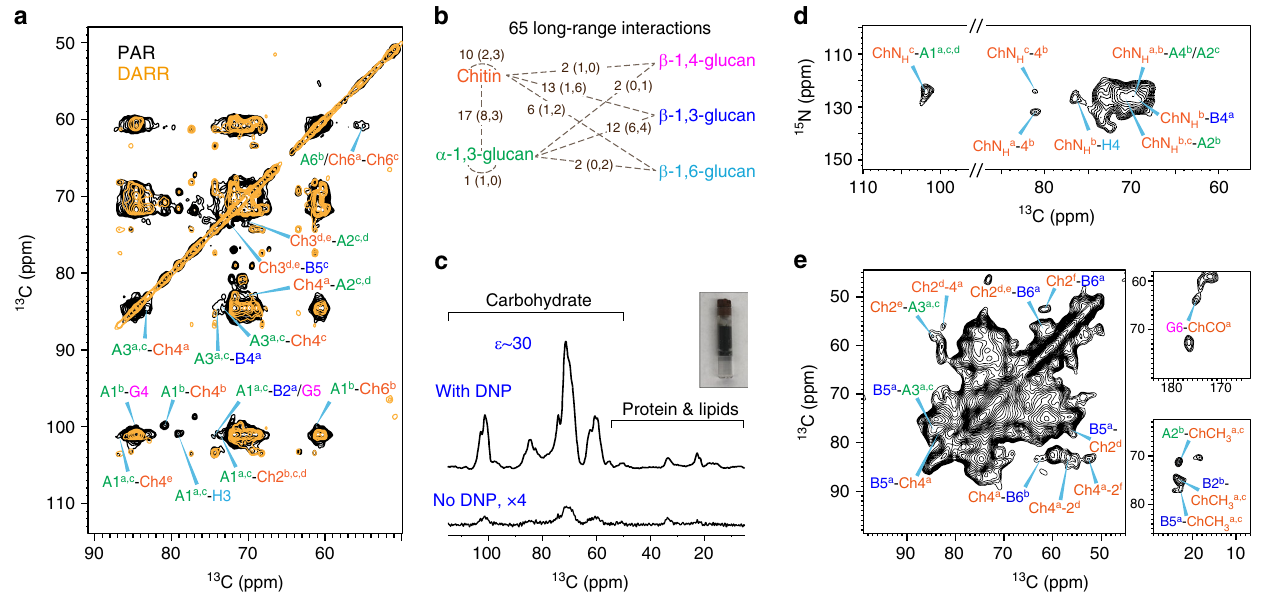
Fig. 3 MAS-DNP solid-state NMR reveals the tight packing of chitin and α -1,3-glucan. a 15 ms 13 C – 13 C PAR spectrum (black) reports many intermolecular cross peaks, mainly between chitin and α -1,3-glucans. A 100-ms DARR spectrum (orange) that primarily detects intramolecular correlations is overlaid for comparison. b Summary of 65 long-range restraints. For each category, the number of all cross peaks and the number of strong and intermediate restraints (in parenthesis) are listed. c Sensitivity enhancement ε on/off of 30-fold was obtained for A. fumigatus . A picture of a DNP sample is also included. d DNP- assisted intermolecular-only 15 N – 13 C correlation spectrum unambiguously detected several chitin – glucan cross peaks. e DNP-assisted chitin-edited spectrum only shows signals from chitin itself or the glucans that are spatially proximal. The DNP experiments were conducted on a 600 MHz/395